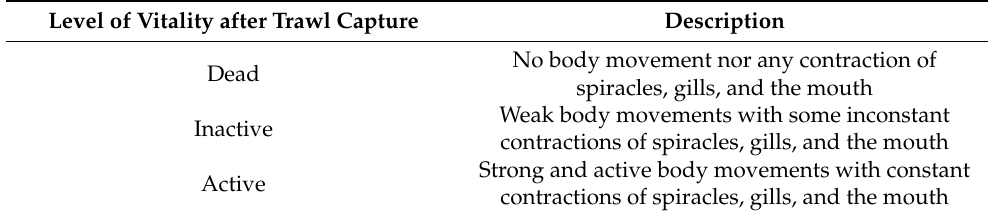
Table 1. The scale of the vitality rates used to assess the resistance to capture of twelve elasmobranch species through a fishery-independent trawl survey in the Asinara Gulf during June–October 2022. Level of Vitality after Trawl Capture Description No body movement nor any contraction of Dead spiracles, gills, and the mouth Weak body movements with some inconstant Inactive contractions of spiracles, gills, and the mouth Strong and active body movements with constant Active contractions of spiracles, gills, and the mouth